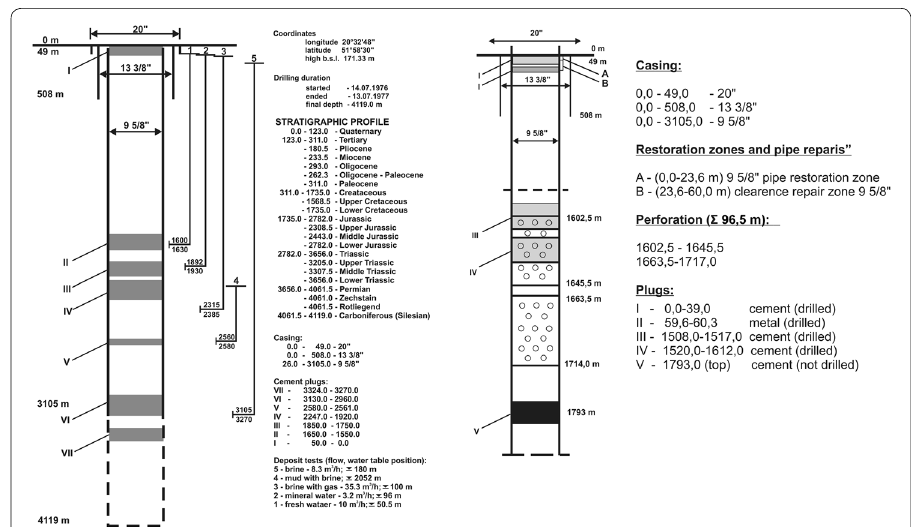
Fig. 4 Mszczonów IG-1 well—1977 (left) and post 1999 reconstruction (right) (Bujakowski et al.